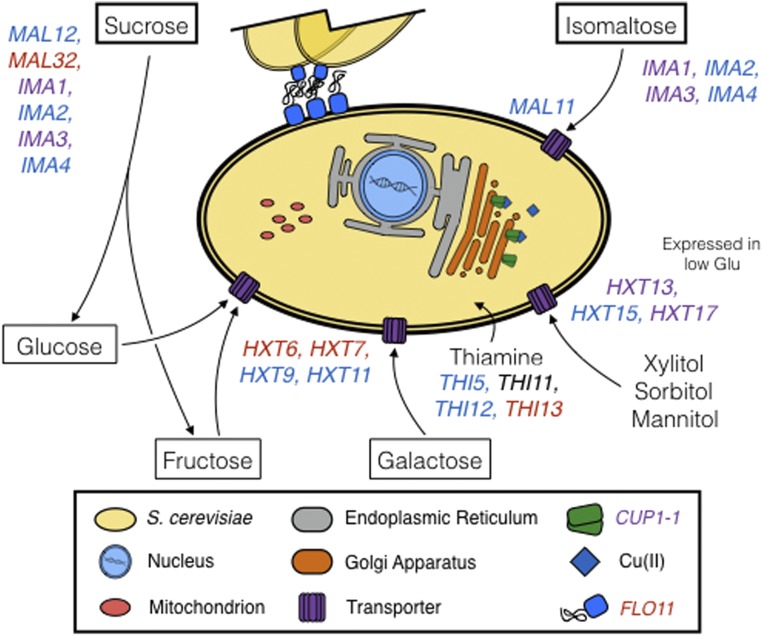
Model summary of CN variable genes in wine yeast strains and their cellular functions. Genes that are deleted among wine strains are blue, whereas those that are duplicated are in red. Genes that were observed to be both duplicated and deleted (IMA1, IMA3, HXT13, and CUP1-1) are purple. Disaccharides are in thick-lined boxes, monosaccharides in thin-lined boxes, and alcohols are unboxed.